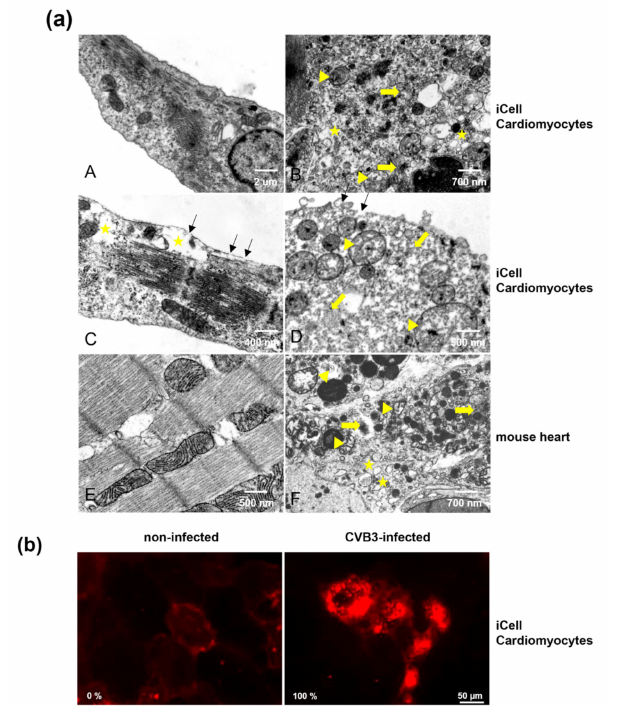
Figure 5. ( a ) Electron microscopy images of iCell ® Cardiomyocytes (A, non-infected, B–D infected) and murine heart tissue (E, non-infected; F, infected). iCell ® Cardiomyocytes were analyzed eight hours post CVB3 infection (MOI 10) and compared with murine heart tissue of CVB3-infected mice obtained during acute infection (eight days pi). Yellow arrows indicate destruction of myofibrils; yellow triangles indicate structural changes in mitochondria; yellow asterisks indicate the evolvement of vesicular structures; black arrows (C, D) indicate the destruction of the cellular membrane, which was observed in > 90% of 100 analyzed cells. D illustrates end-stage infection with final cellular lysis. ( b ) LIVE/DEAD staining of iCell ® Cardiomyocytes with an amine-reactive dye for analysis of cell membrane integrity. Cells were infected with MOI 10 and analyzed after eight hours. The percentage of positively stained cells is indicated in the left lower corner,